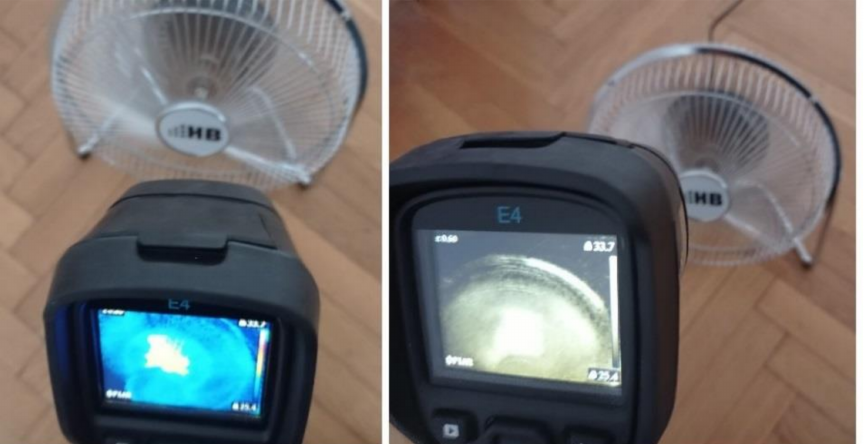
Figure 11. Thermographic measurements for the BLDC motor